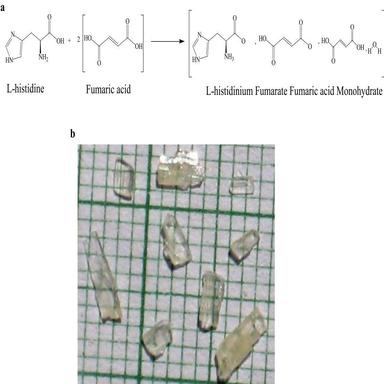
(a) Reactions scheme for LHFFAM compound. (b) Single crystals of LHFFAM slow evaporation technique.